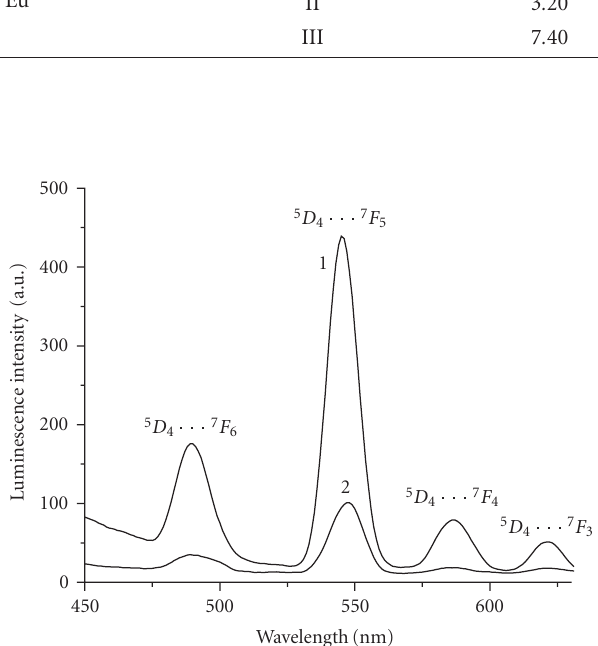
Figure 2: Luminescence emission spectra of 8 10 (cid:0) 5 M of (I) in (1) DMSO and (2) ethylacetate the presence of 2 (cid:0) at λ ex = 330 nm.